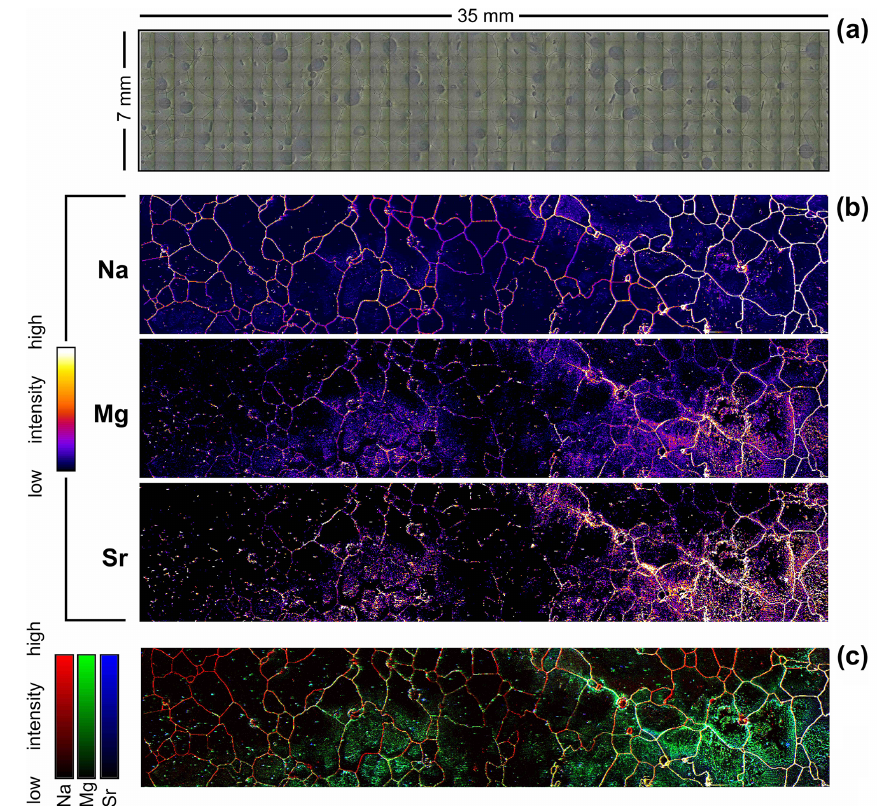
Figure 3. EPICA Dome C 1065 sample from MIS 2. Panel (a) shows an optical image; panel (b) elemental maps of Na, Mg and Sr, respectively, from the same area; (c) composite RGB map of the three elements. The main core axis runs from left (top) to right. Table 3. Results from basic statistics after image segmentation into grain boundaries and grain interiors. Note that Na, Mg and Sr are intensities in counts, whereas Na / Mg, Na / Sr and Mg / Sr are reported as elemental ratios (see text). EDC MIS 2 EDC MIS